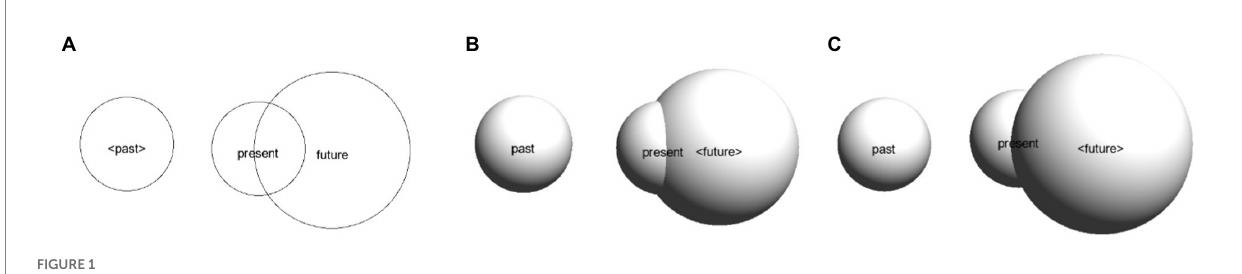
FIGURE 1 Examples of the screen images of CT (A) and ST (B,C)